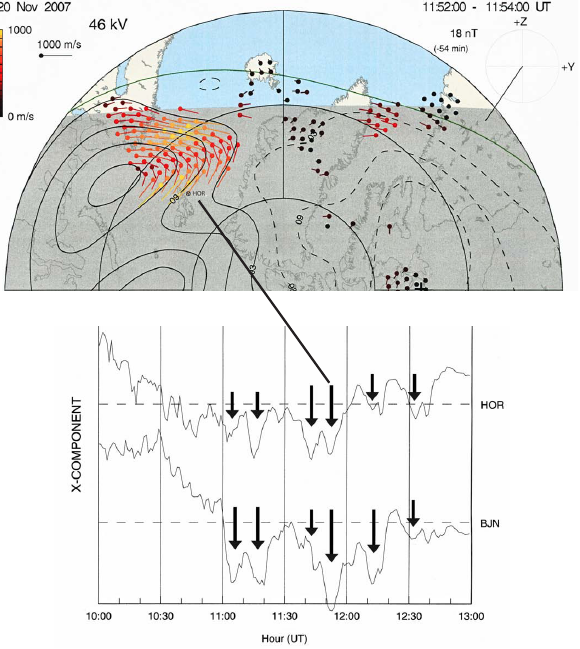
Fig. 10. SuperDARN convection plot for 11:52–11:54UT (top) and ground magnetic perturbations (marked by arrows) in two Svalbard stations (HOR and BJN) during the interval 10:00–13:00UT.